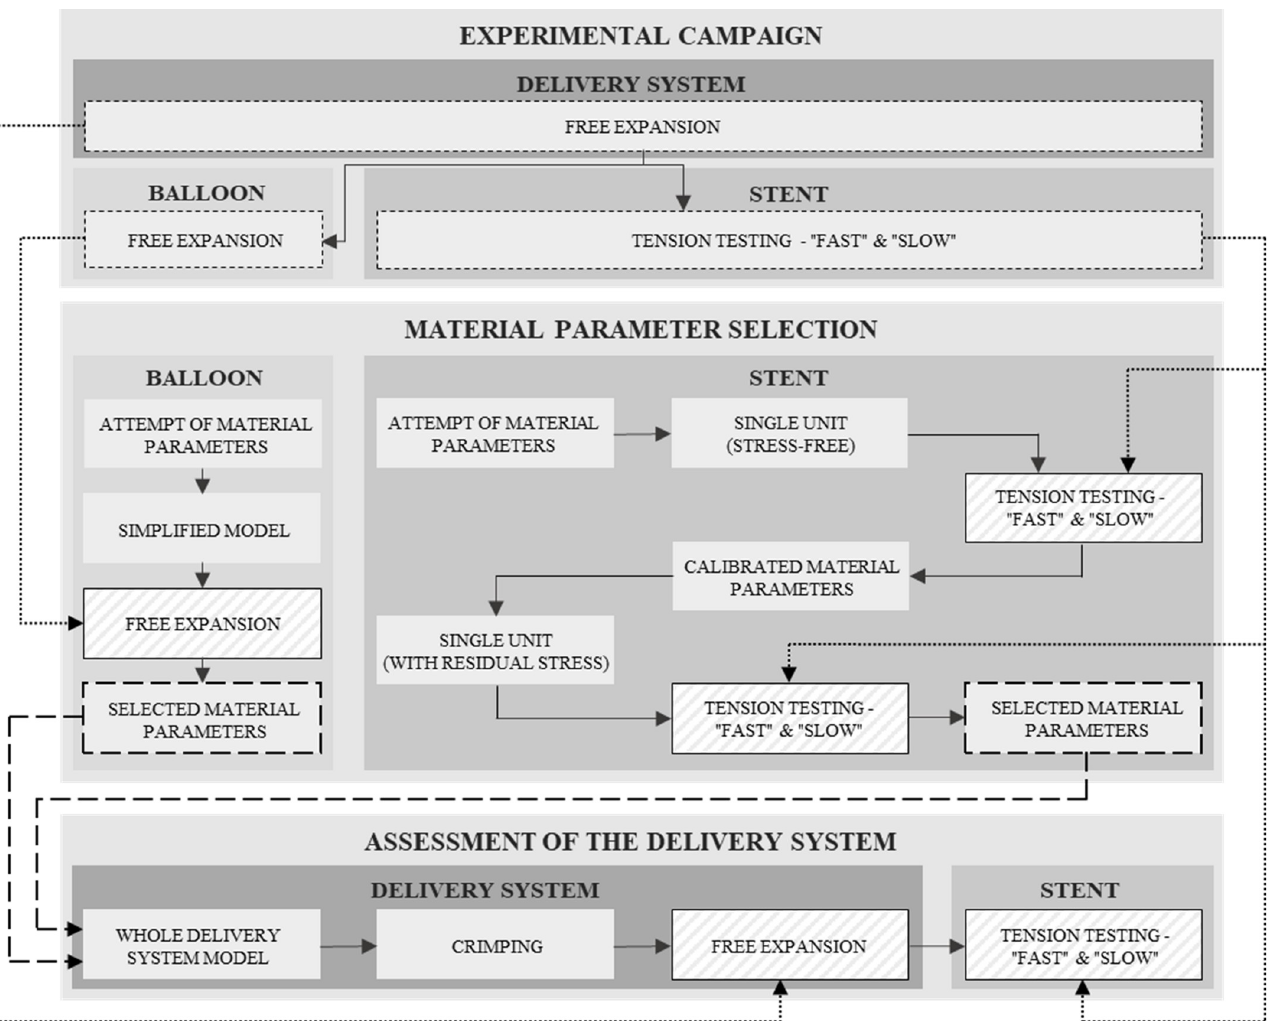
Fig 1. Schematic representation of the workflow of the